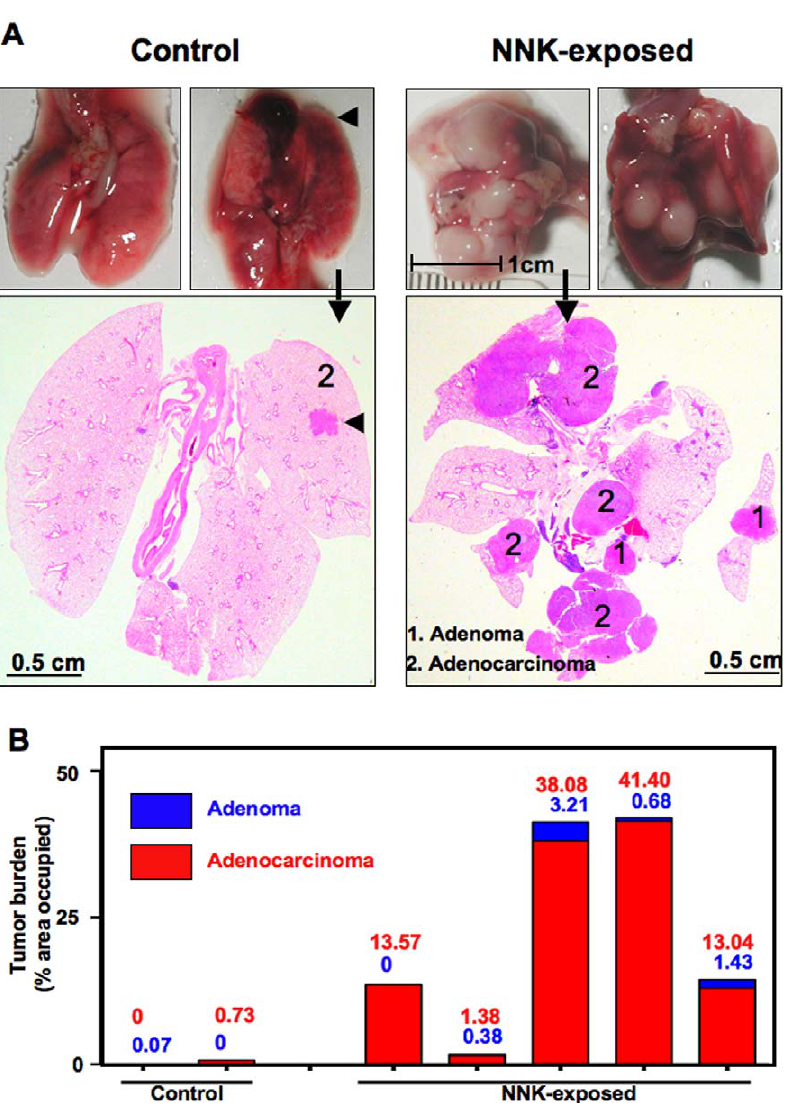
Figure 3. Increased lung tumor burden in NNK-exposed Gprc5a -knockout mice. A .Gross and macroscopic images representing total lungs excised from two mice each injected i.p with control saline (left) or NNK (right). Arrows indicate gross lung images representing selected H& E stained histological sections of total lungs from both groups and arrowheads indicate presence of a lung tumor (adenomas, 1; adenocarcinomas, 2). B . Lung tumor areas were quantified by Image-J software to assess tumor burden displayed in the graph as percentage occupied of total area.